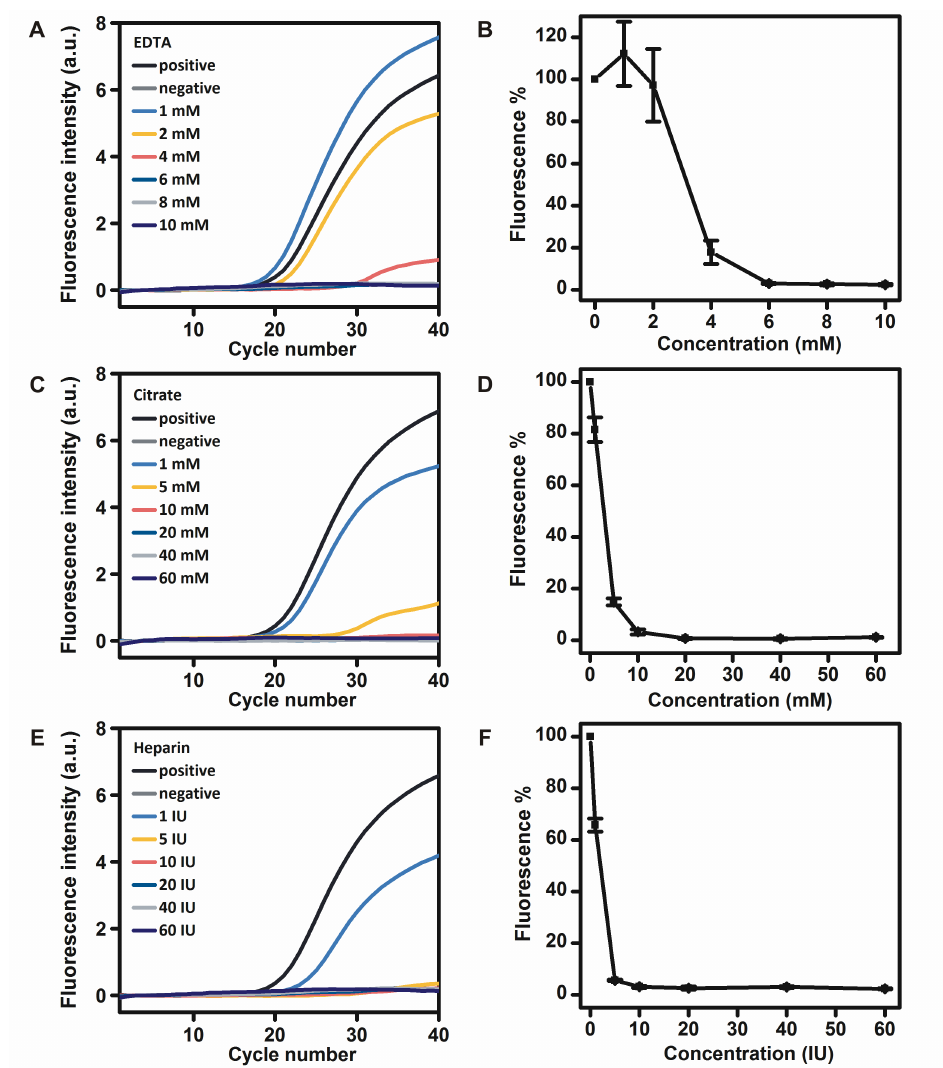
Fig 2. Inhibitory effects of different concentrations of EDTA A, B), citrate C, D), and heparin E, F) on the RNA detection by r Tth